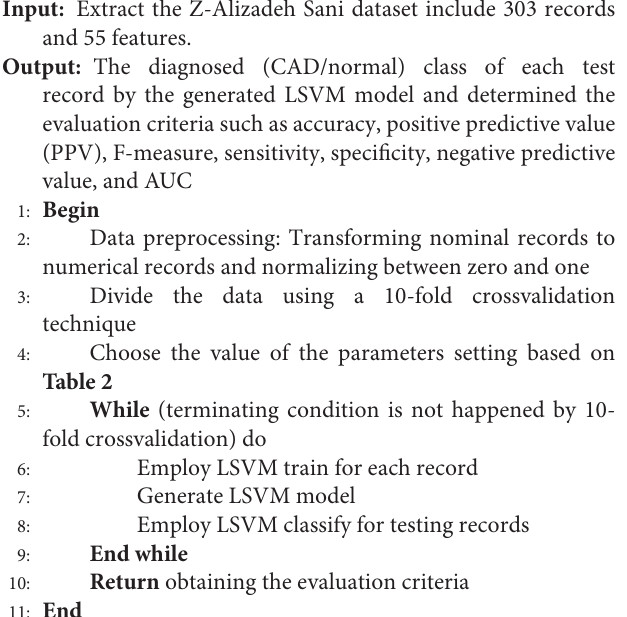
Algorithm 1 : The used LSVM method for CAD diagnosis.